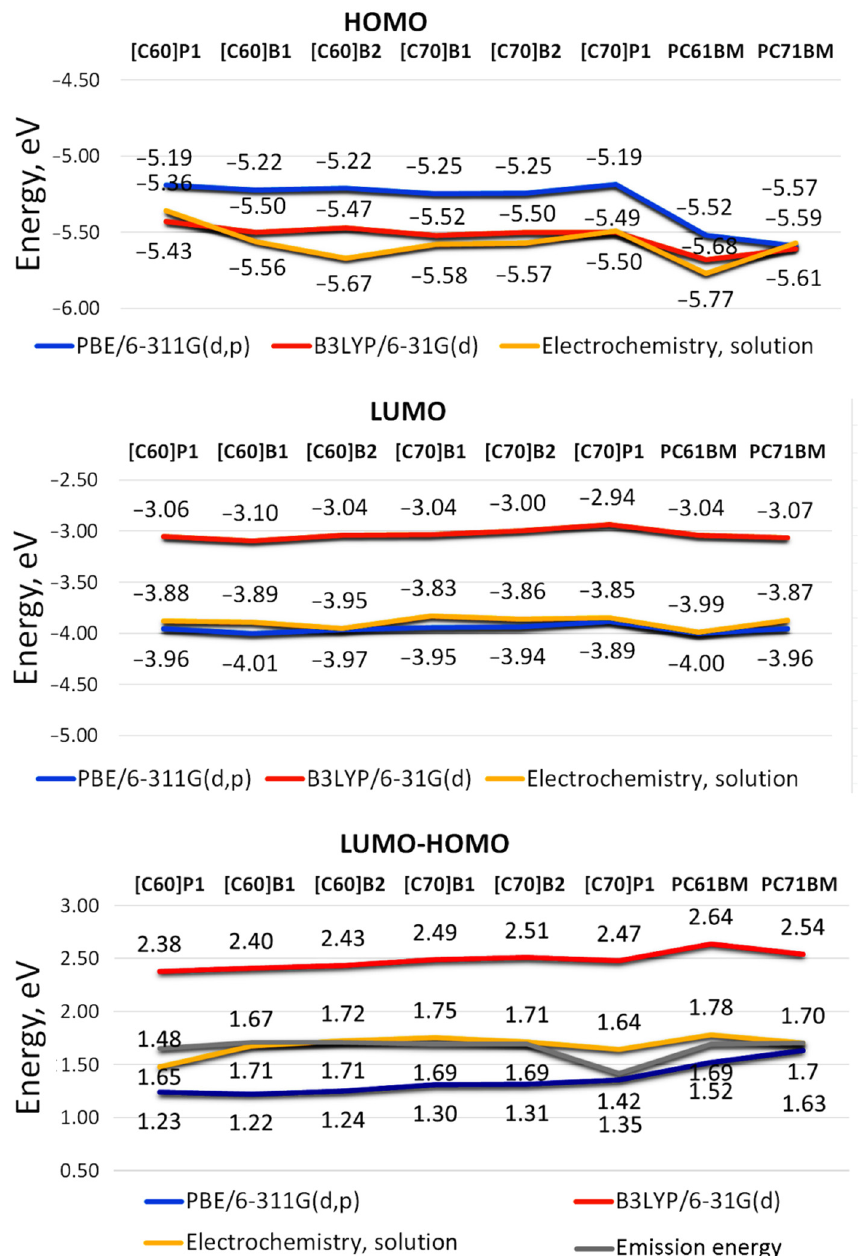
Figure 3. Calculated by DFT/B3LYP/6-31G(d) and DFT/PBE/6-311G(d,p) method and experimentally measured by cyclic voltammetry and luminescence spectroscopy HOMO, LUMO and LUMO-HOMO energies for investigated pyrene C 60 and C 70 fullerene derivatives. The HOMO-LUMO energy gaps of PC60BM calculated with B3LYP and PBE method are similar to the results in the literature [22].